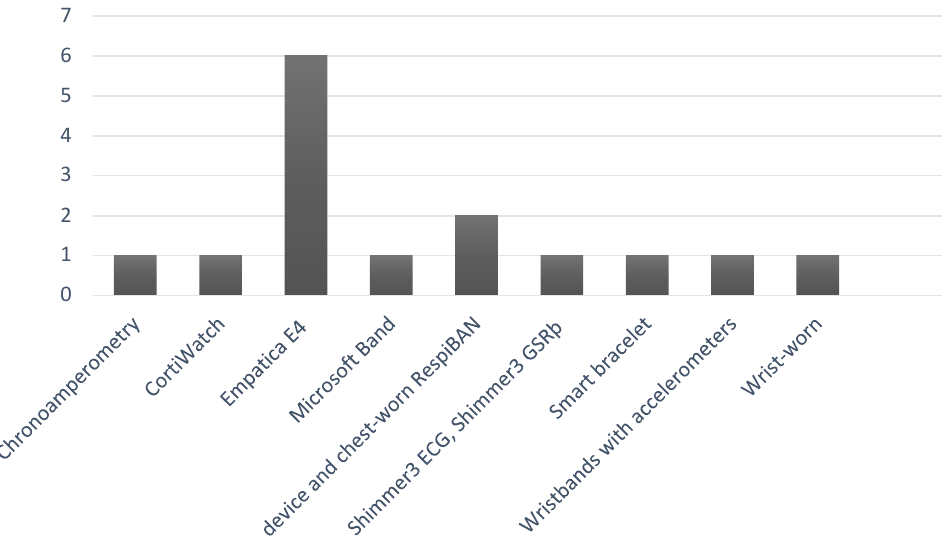
Figure 4. Different sensors were employed in the selected work. The X-axis corresponds to the type of wrist wearable in the works investigated. The Y-axis shows the number of times the device was encountered in the research.